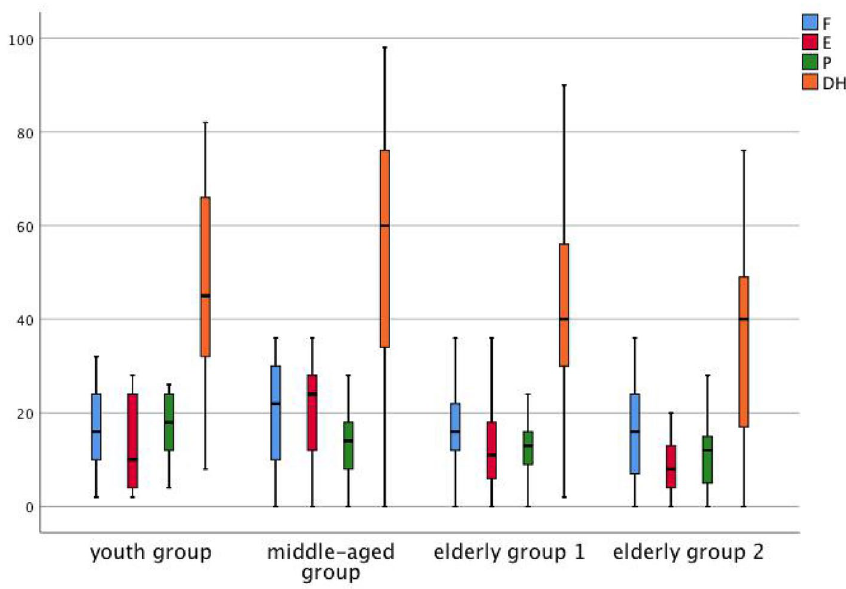
Figure 4. Box plots of DHI score in each group.